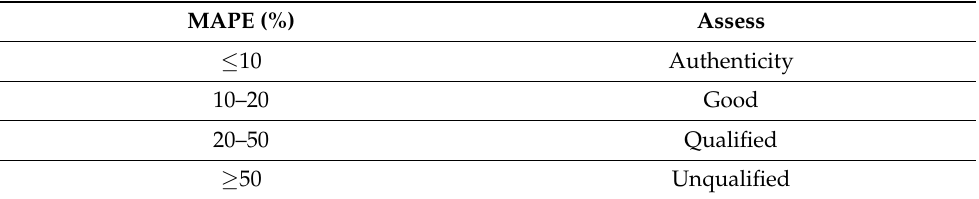
Table 2. The grades of